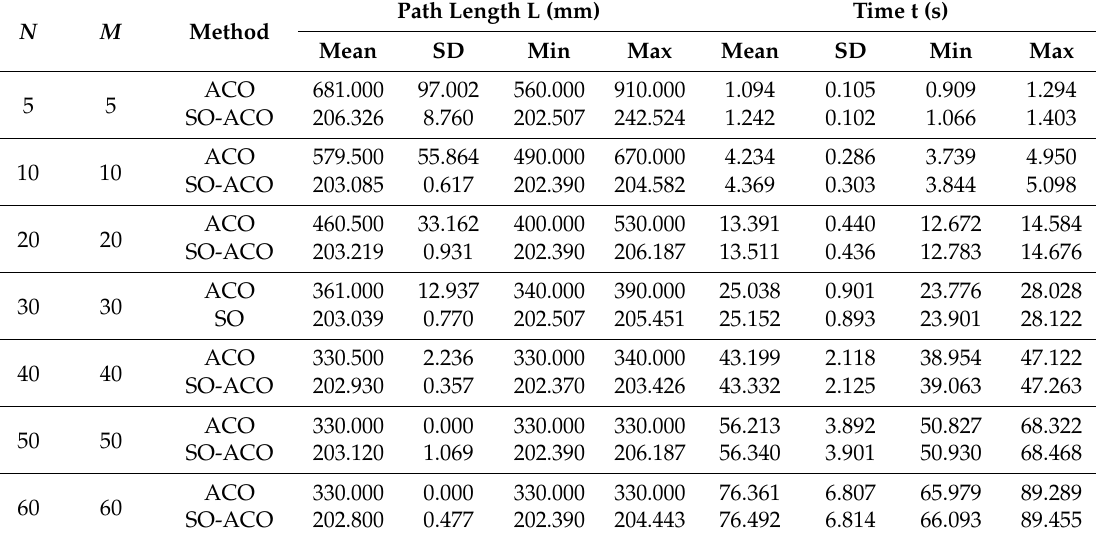
Table 3. Comparison of the results optimized based on two algorithms.